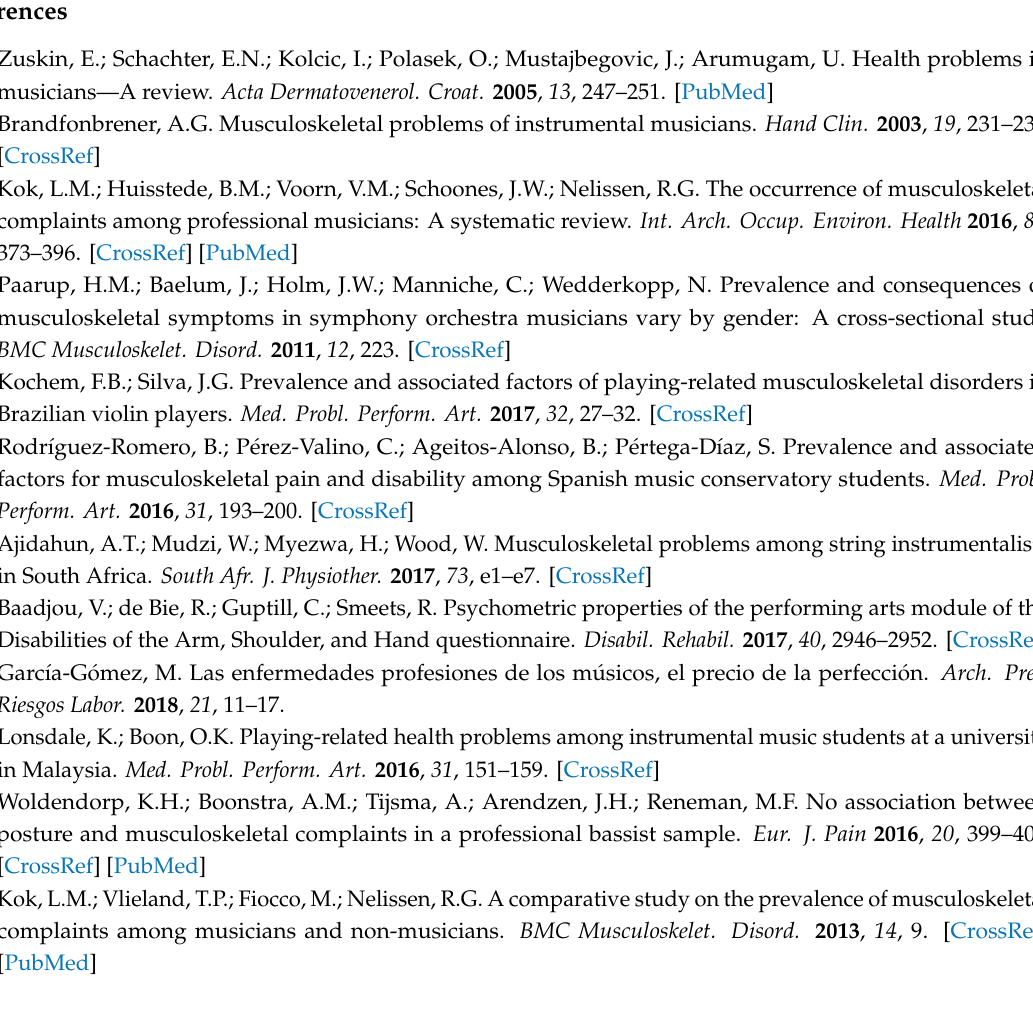
Table S1: STROBE Statement—Checklist of items that should be included in reports of cross-sectional studies ., Table S2: Checklist for Reporting Results of Internet E-Surveys